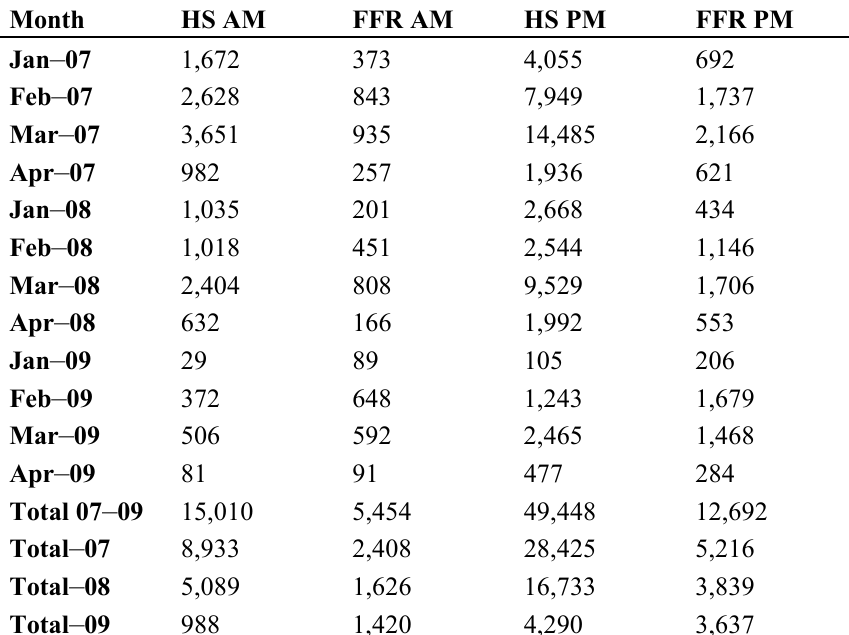
Table 3. Number of MODIS hotspots (HS) within 187 protected areas (130 National Parks and 57 Wildlife Sanctuaries) from FIRMS and number of fires from daily forest fire reports (FFR),